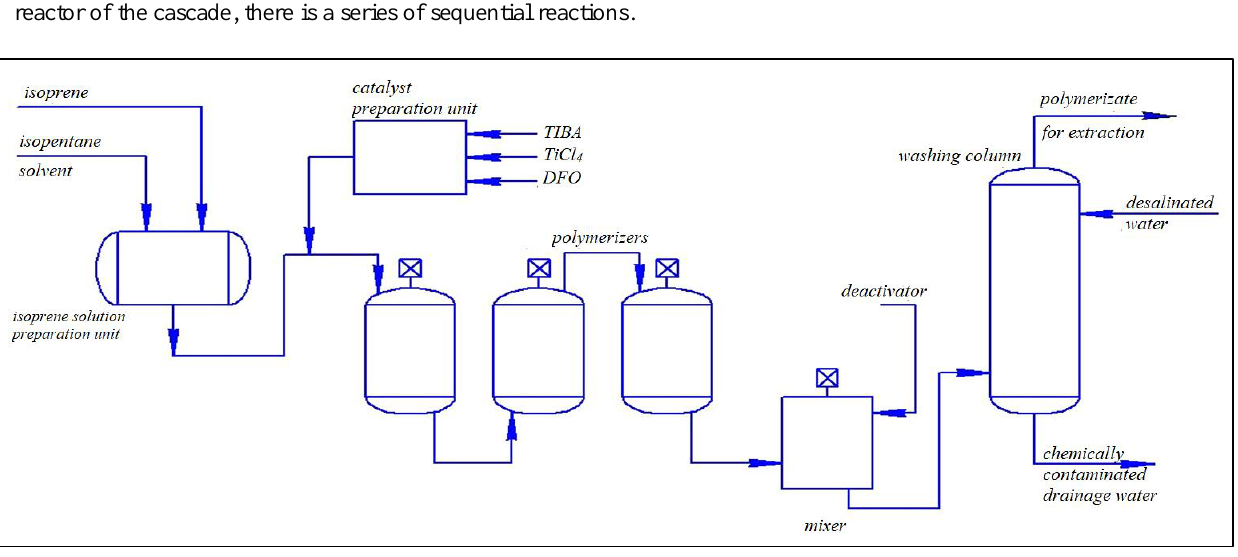
Figure 1. Scheme of continuous polyisoprene